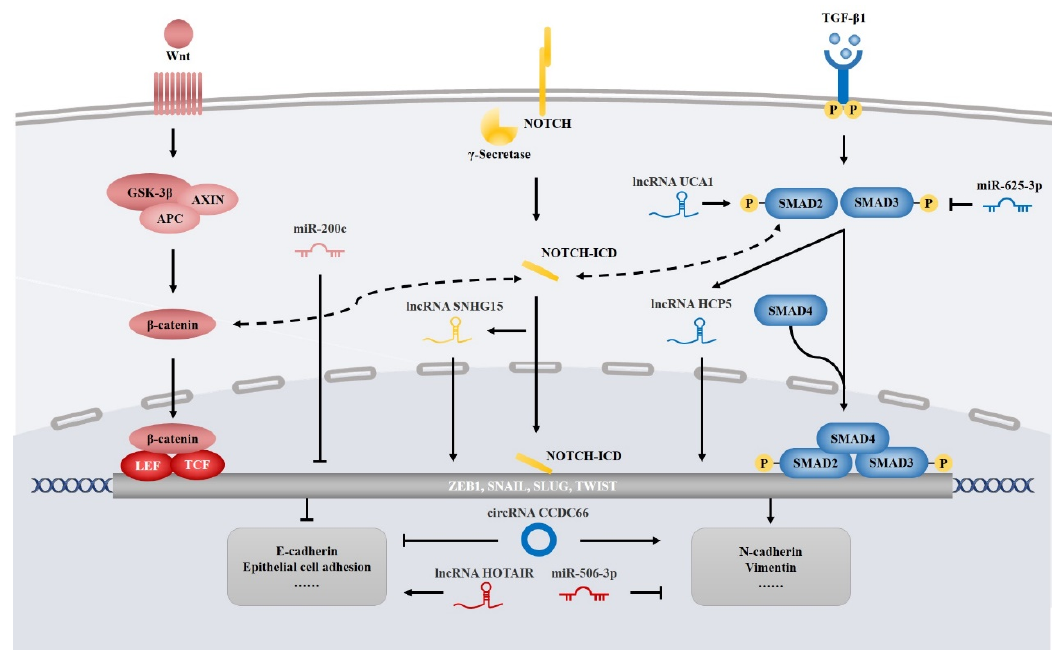
Figure 3. NcRNAs involved in EMT. Dysregulated ncRNAs play an important role in EGFR-TKI resistance via EMT regulation. Abbreviations: APC, adenomatous polyposis coli protein; AXIN, axis inhibition protein; E-cadherin, epithelial cadherin; EMT, epithelial-mesenchymal transition; GSK3 β , glycogen synthase kinase-3 β ; LEF, lymphoid enhancer-binding factor; N-cadherin, neural cadherin; NOTCH-ICD, intracellular domain of the NOTCH receptor; TCF, T cell factor; TGF- β , transforming growth factor ‐β .